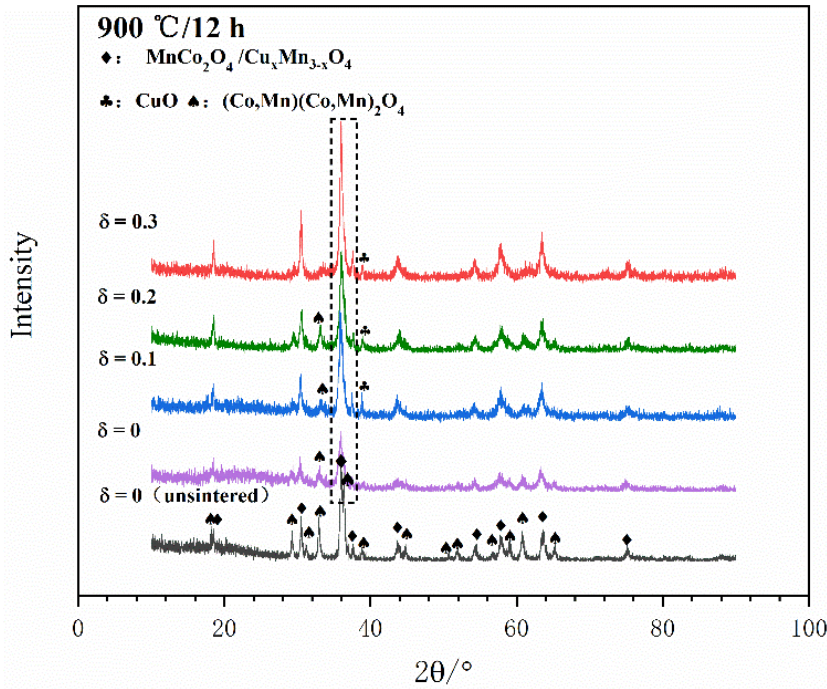
Figure 3. XRD patterns of Mn 1.5 Co 1.5 O 4 powder and Cu δ Mn 1.5 − 0.5x Co 1.5 − 0.5x O 4 powder.